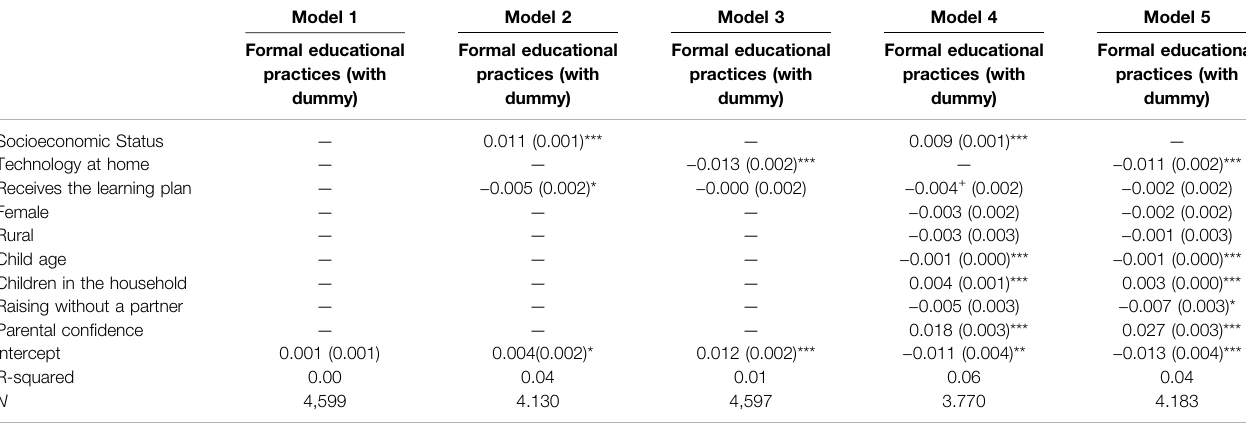
TABLE 4 | Regression model for formal educational practices.